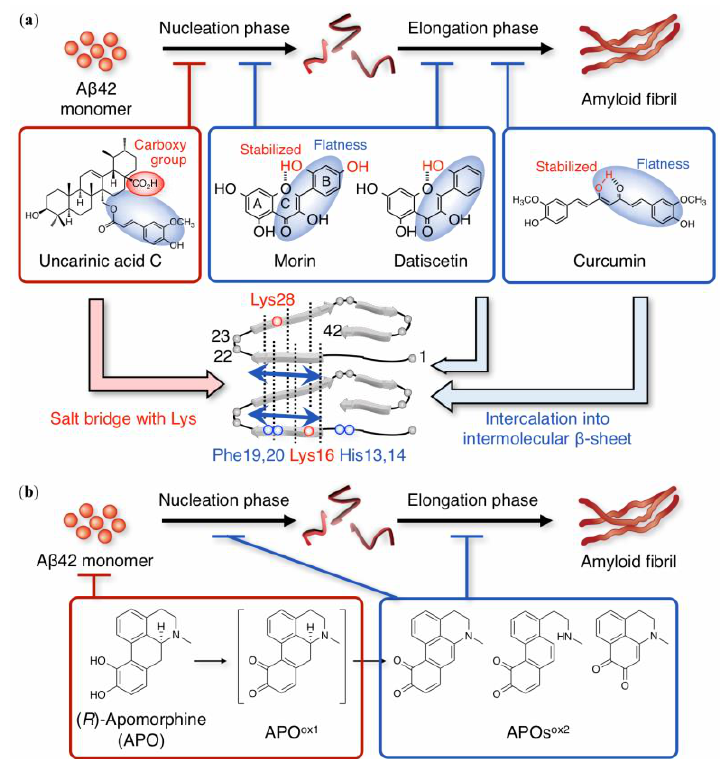
Figure 3. ( a ) Overview of aggregation inhibitors of non-catechol-type flavonoids. Morin and datiscetin inhibited both nucleation and elongation phases during the aggregation of A β 42 by interacting with His13 and 14, and Phe19 and 20. ( b ) Mechanism of A β 42 aggregation suppression by apomorphine (APO): APO is first autoxidized to the labile form (APO ox1 ), which includes o -quinone and has a biphenyl structure; APO ox1 forms the Michael adduct with Lys16 and 28 in monomeric A β 42 during the nucleation phase, leading to the production of a secondary oxidized form (APOs ox2 ) during both nucleation and elongation phases. In ( a , b ), only the on-pathway route is indicated.